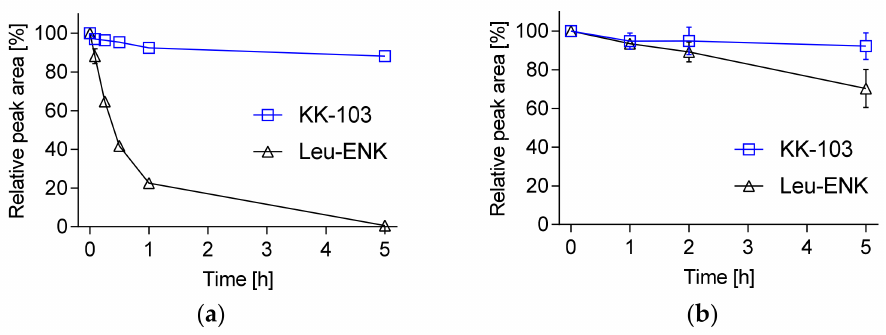
Figure 4. In vitro stability of KK-103 compared to native Leu-ENK in ( a ) plasma and ( b ) CSF. Data = mean ± SEM, n = 3. SEM bars are narrow and are within the data